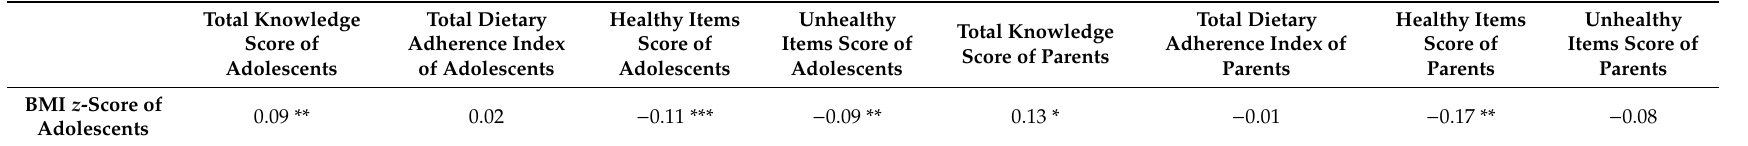
Table 5. Correlations between knowledge and adherence scores and BMI z -scores of